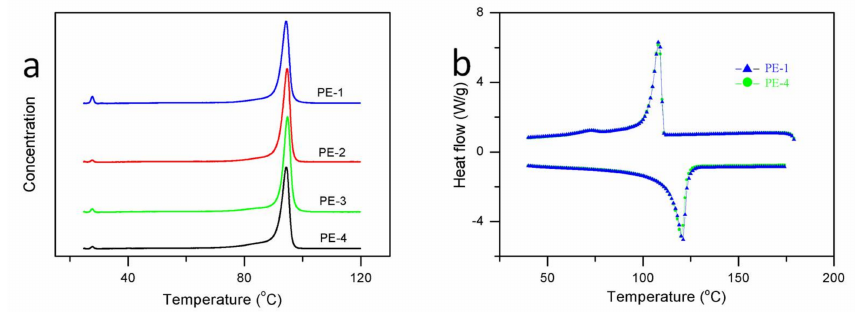
Figure 5. ( a ) TREF analysis of PE copolymers produced from POPs- and silica-supported metallocene catalysts; ( b ) DSC analysis of PE-1 and